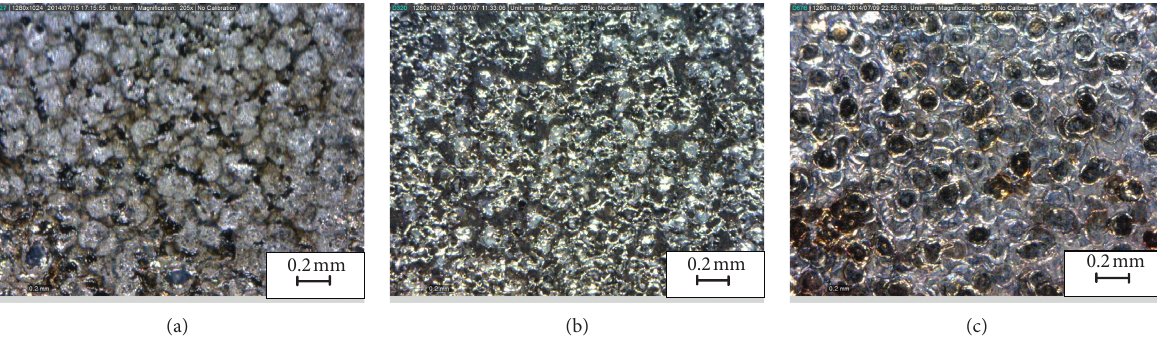
Figure 3: EDM machined surface comparison in 3 different working mediums: (a) discharge in air; (b) discharge in kerosene; and (c) discharge in water-based